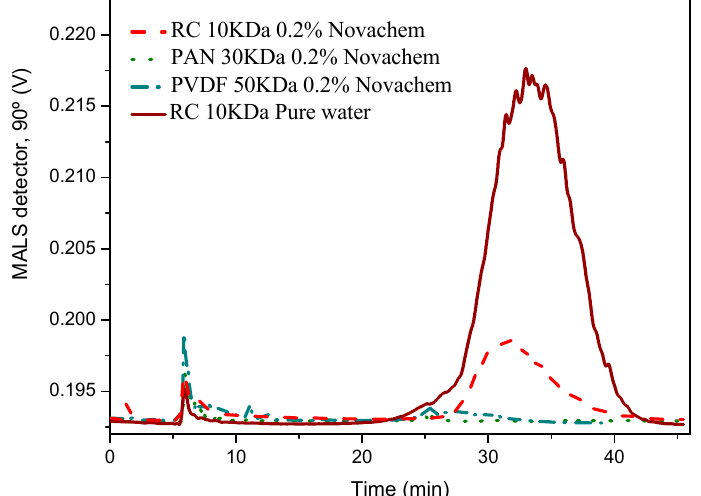
Figure 7. Asymmetric flow field flow fractionation (AF4) fractograms of GNS using regenerated cellulose (RC), polyacrylonitrile (PAN) and Polyvinylidene fluoride (PVDF) as membranes and Novachem and water as carriers.